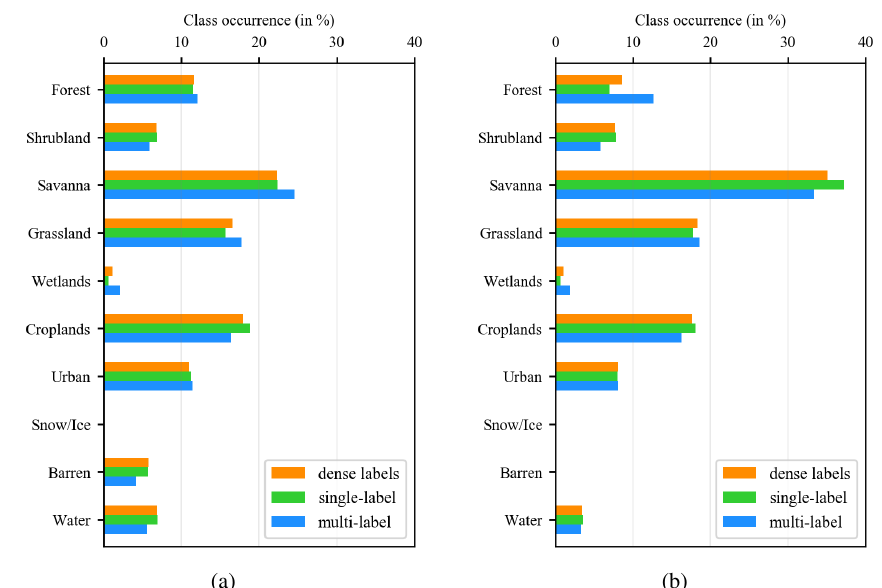
Figure 2: Class occurrences in the different formats of the SEN12MS dataset. (a) Training split, (b) hold-out testing split. Note that the number of Barren samples in the dense and the multi-label variant of the test set is actually not zero, but very small in comparison to the other classes. Table 3: Validation of the Scene Labels with Respect to